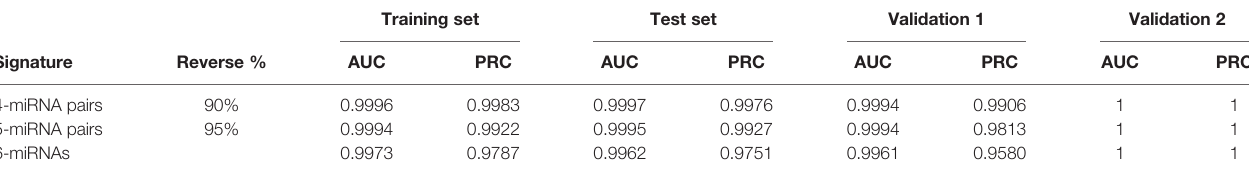
TABLE 2 | Evaluation of the performance of three miRNA